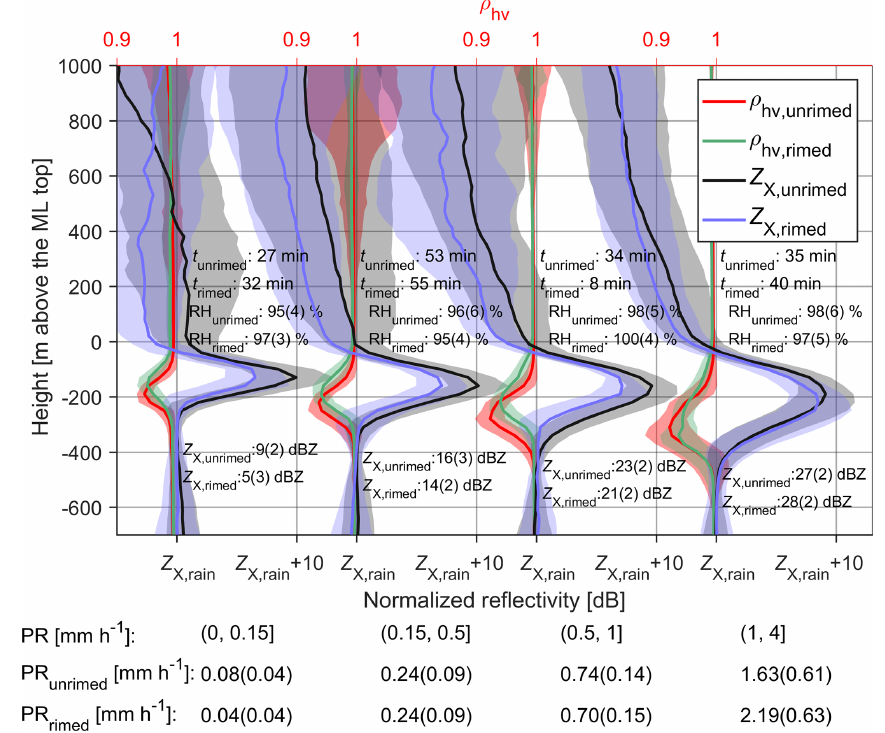
Figure 5. Normalized X-band radar profiles grouped by PR. t unrimed and t rimed indicate the total observing time in each group for unrimed and rimed cases, respectively. The median values of X-band reflectivity at the ML bottom for unrimed ( Z X , unrimed ) and rimed ( Z X , rimed ) cases are marked just below the ML bottom with the standard values in brackets. The median and standard deviations (in parentheses) of relative humidity (RH) at the ML top for unrimed (RH unrimed ) and rimed (RH rimed ) cases in each group are presented near the ML top. The median and standard deviations (in parentheses) of PR for unrimed (PR unrimed ) and rimed (PR rimed ) cases in each group are presented in the lower part. Shaded regions represent the standard derivation.